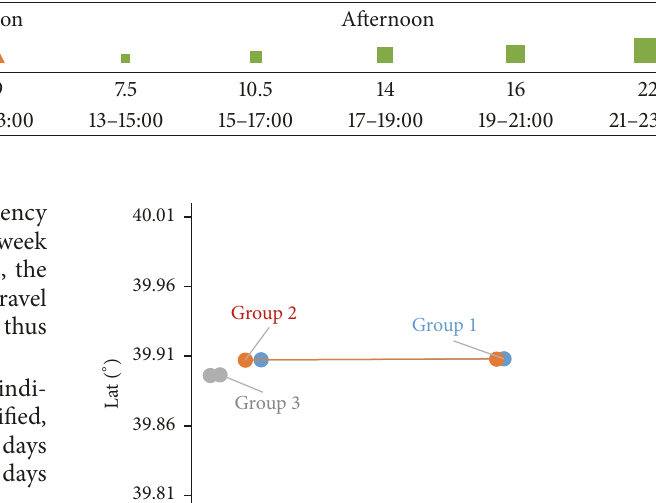
Table 4: Symbols used for travel time classification.